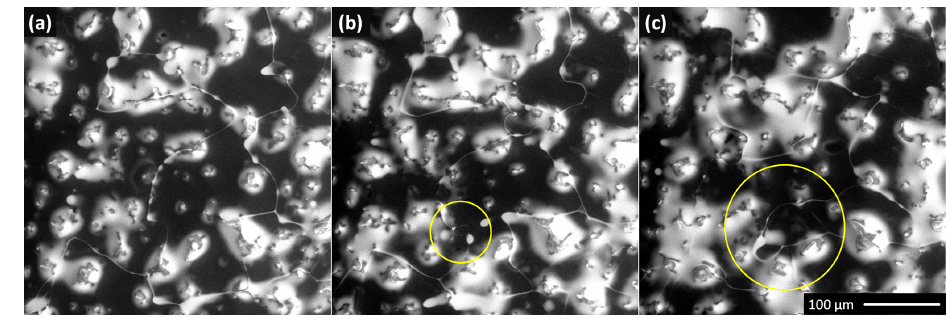
Figure 7. The ice surface dynamics observed at − 23 . 4 ◦ C and 500Pa. Newly formed ice grains are